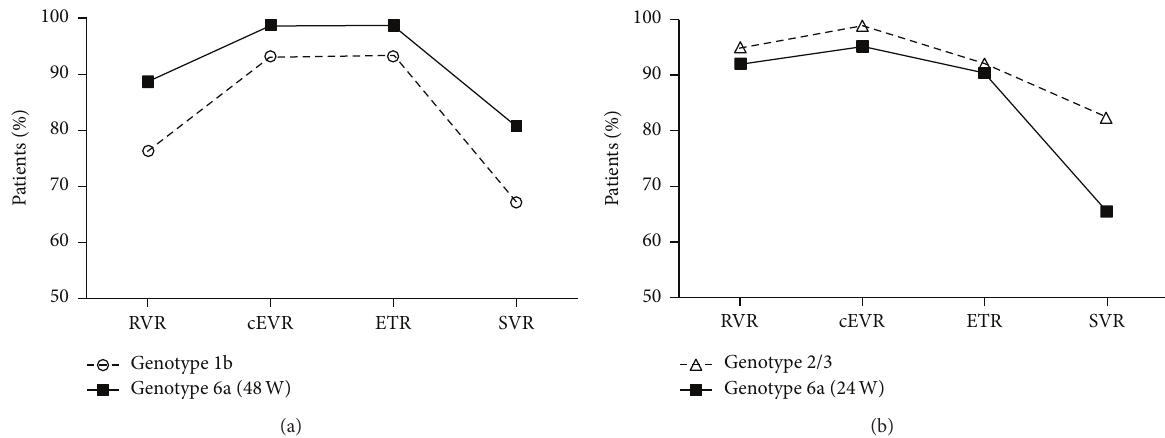
Figure 3: The trend graph of virological response to combined therapy among patients with HCV-1b and HCV-6a-48W (a), HCV-2/3 and HCV-6a-24W (b). RVR, rapid virologic response; cEVR, complete early virologic response; ETR, end-of-treatment response; SVR, sustained virologic